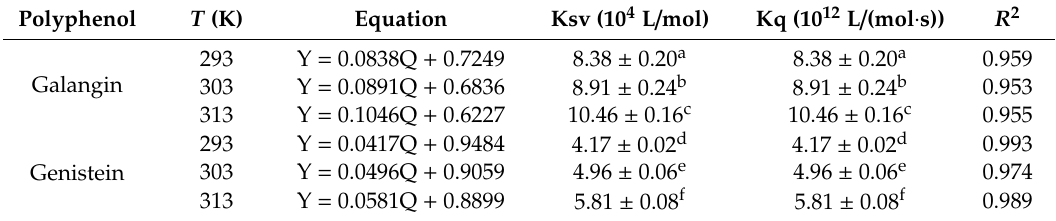
Di ff erent lowercase letters after the data as superscripts in the same column indicate that the means of ANOVA using Duncan’s multiple comparison test di ff er significantly ( p < 0.05). The critical R 0.01 value for linear regression is 0.798 ( n = 9).